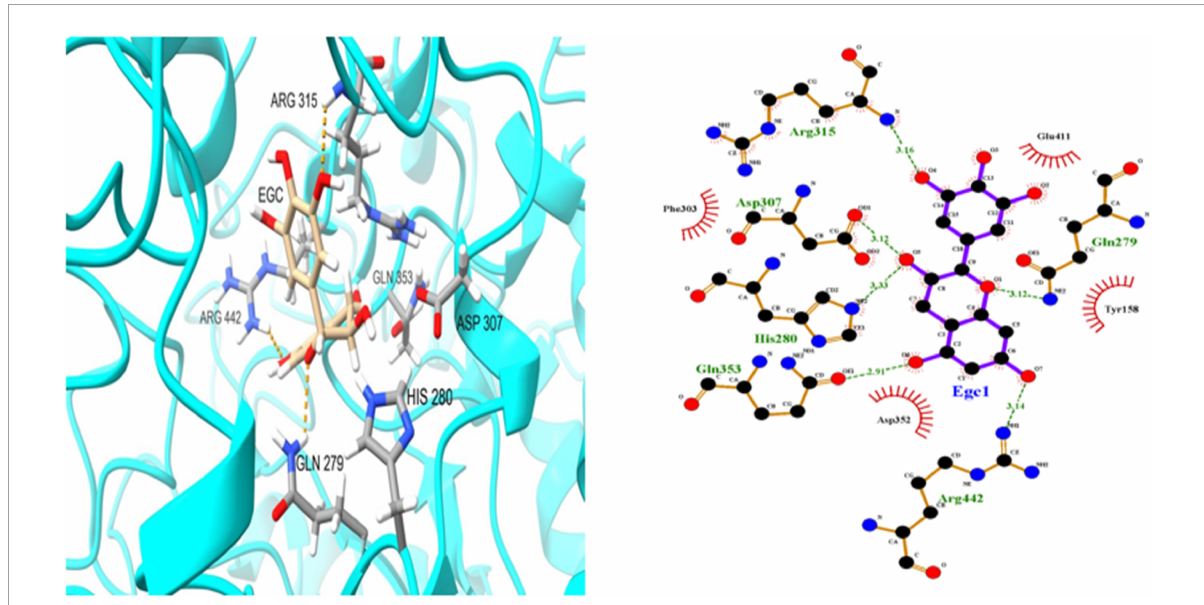
FIGURE6 Molecular docking simulation diagrams of α -glucosidase and epigallocatechin (in 2-dimensional graphic, the green dotted line represents the hydrogen bond, and the red arc represents a hydrophobic interaction).